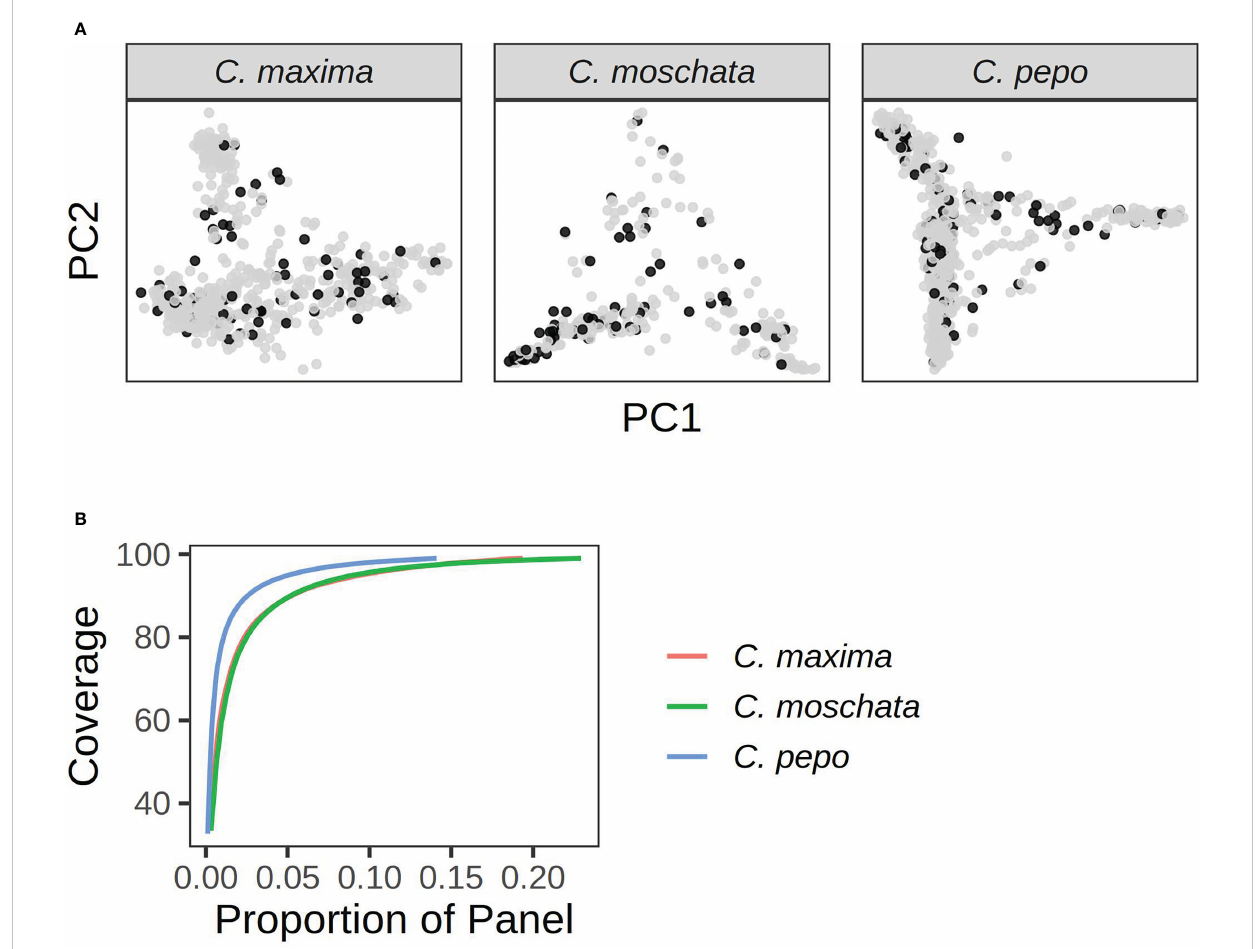
FIGURE 8 Results from running GenoCore in each of the panels. (A) shows the PCA plots for each panel with accessions selected by GenoCore represented as black points. (B) shows the proportion of total accessions needed to obtain a certain coverage of